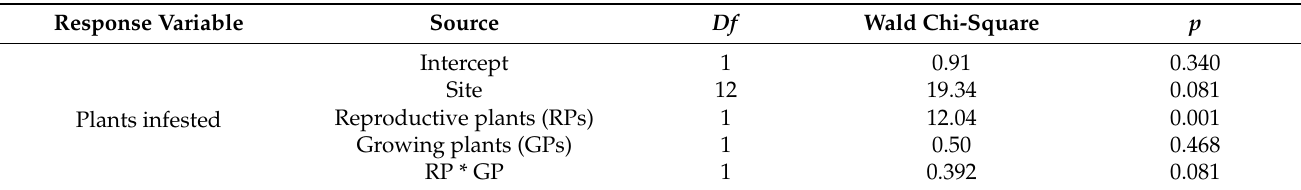
Table 3. Generalized linear model with negative binomial distribution results evaluating the effect of different variables on the plants infested a .